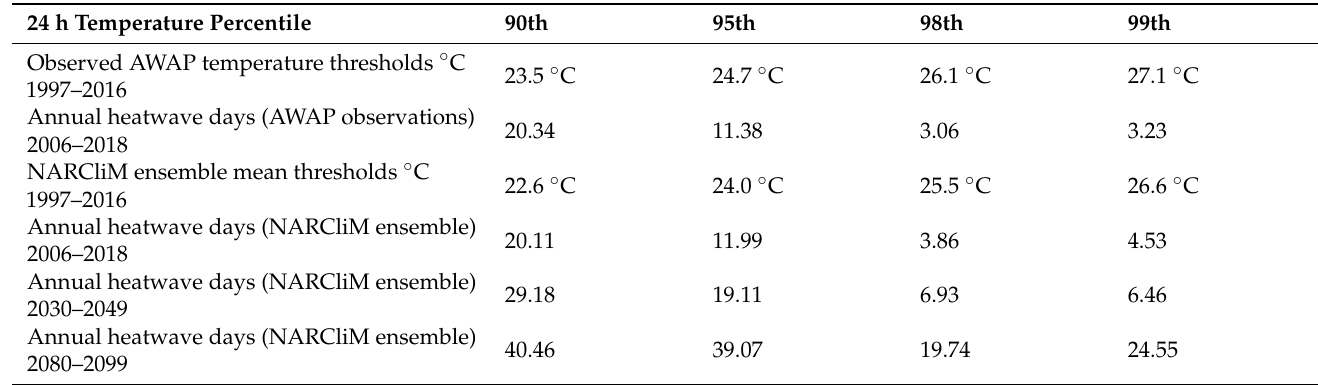
Table 2. Percentile temperature thresholds and numbers of heatwave days from observations and NSW and ACT Regional Climate Modelling